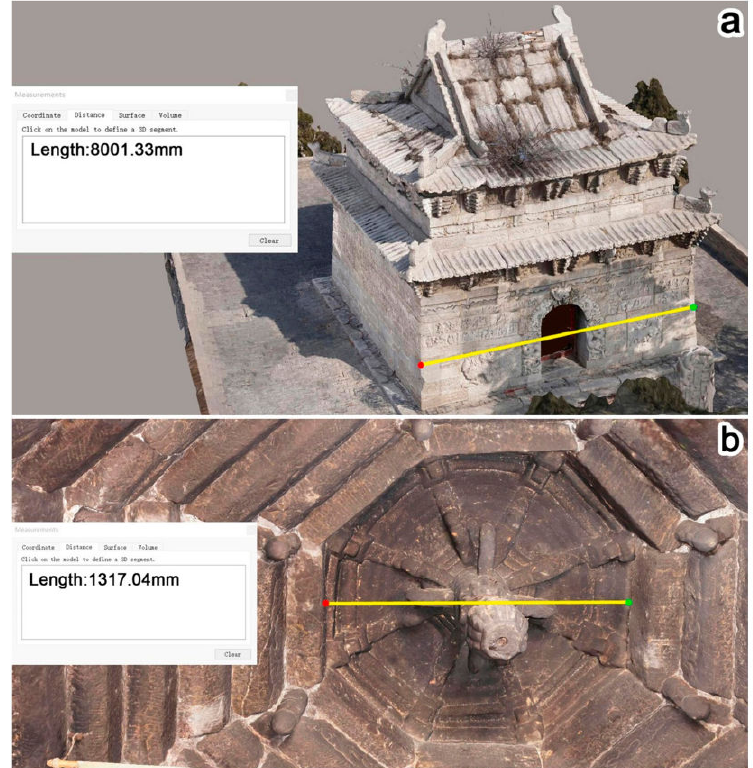
Figure 8. Measurable model established by smart3d software ( a ) Measurement for external model; ( b ) Measurement for the internal